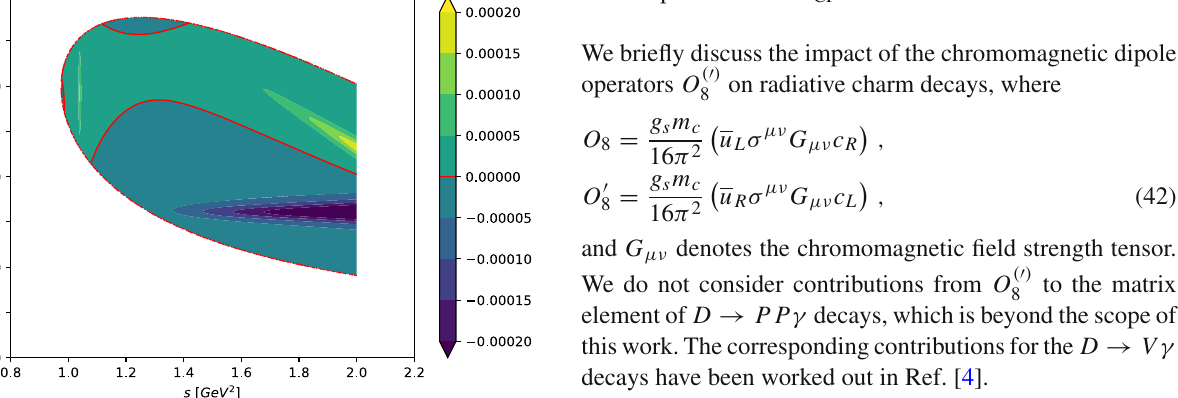
( s , t ) for D → K + K − γ decays based on CP